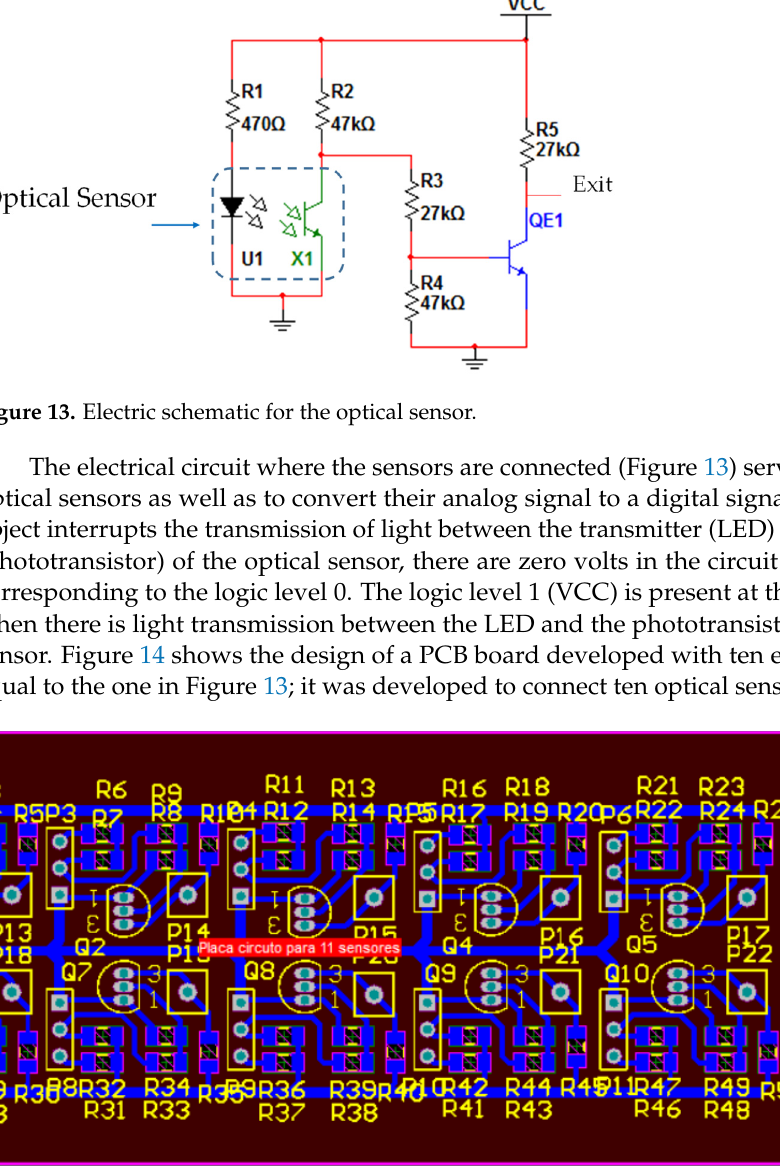
Figure 14. Board with ten electrical circuits for connections to optical sensors (drawing in the bottom layer).